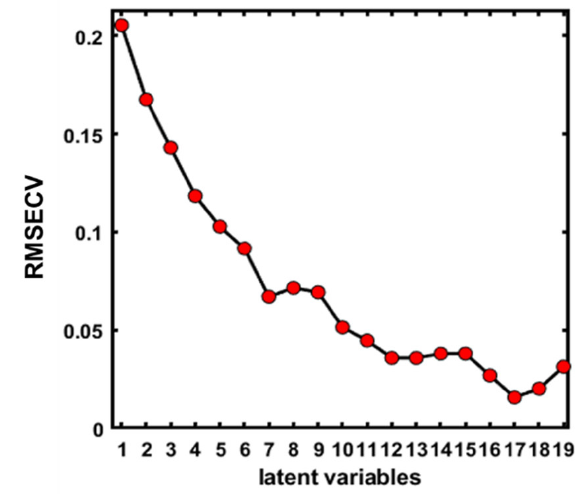
Figure 5. The optimal number of latent variables (LVs) for the full spectral data.